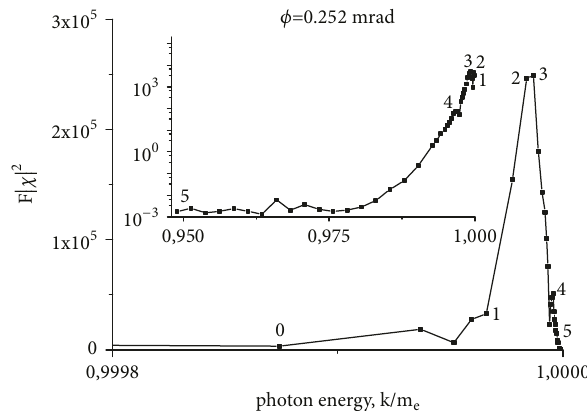
Figure 7: The same as in Figure 6 except for the angle 𝜙 = 0.252 mrad and 𝑘 0 = 0.9998 .